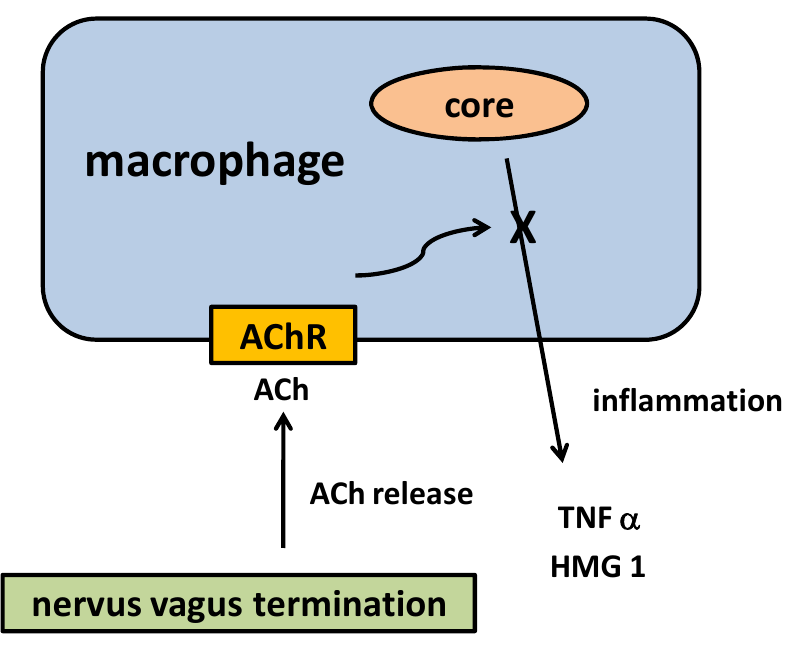
Figure 2. Scheme of cholinergic anti-inflammatory pathway: ACh—acetylcholine; TNF α —tumor necrosis factor α ; HMG 1—high-mobility group protein